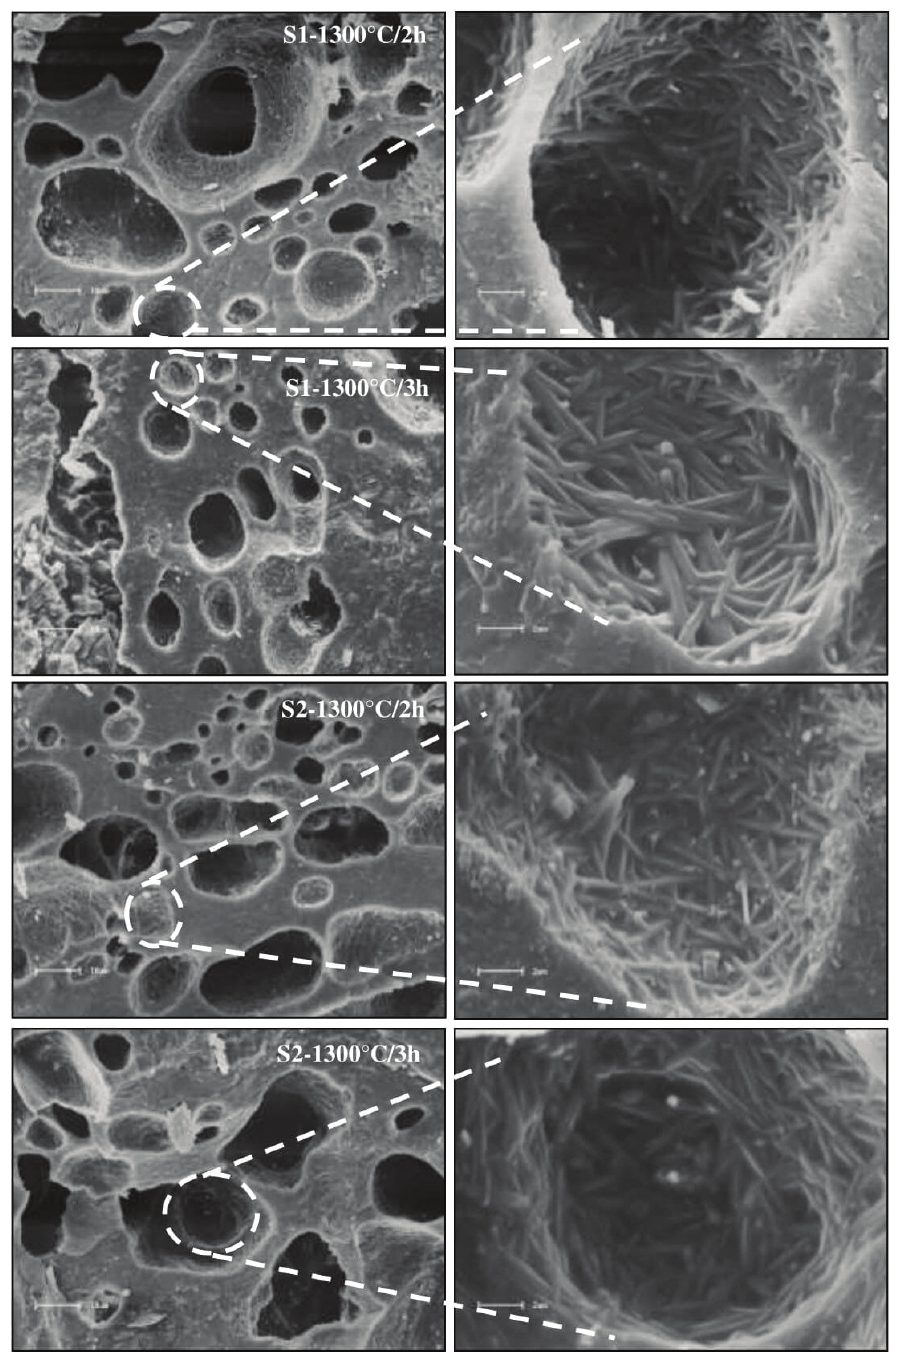
Figure 4. SEM micrographs of the fracture surface of specimens obtained from formulations S1 and S2 sintered at 1300ºC with a dwell time of 2 and 3